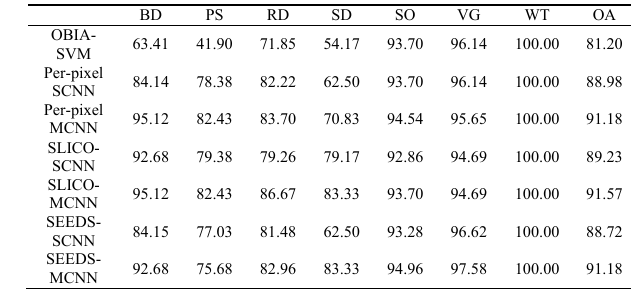
Table 2. Classification accuracy (In percentage) comparison of Suburban scene (BD: Building, PS: Parking space, RD: Road, SD: Shadow, SO: Soil, VG: Vegetation, WT: Water,